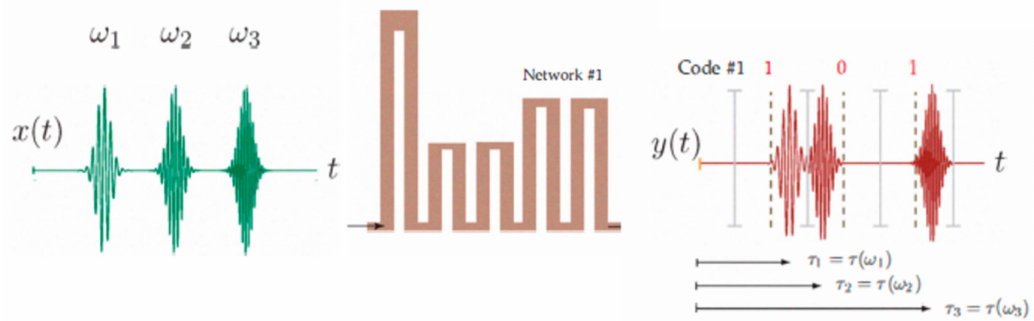
Figure 9. Chipless-RFID tag proposed by Gupta et al. fed with three Gaussian pulses with frequency ω ω ω 1 , 2 , and 3 and an example of PPM encoding. Figure extracted from